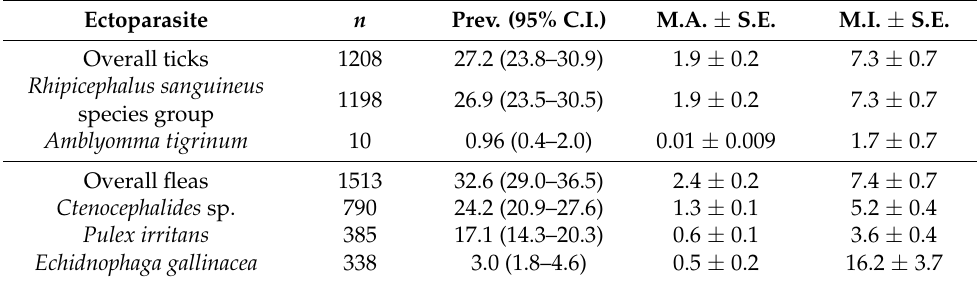
Table 5. Overall observed prevalence, mean abundance, and mean intensity of ectoparasites on dogs in